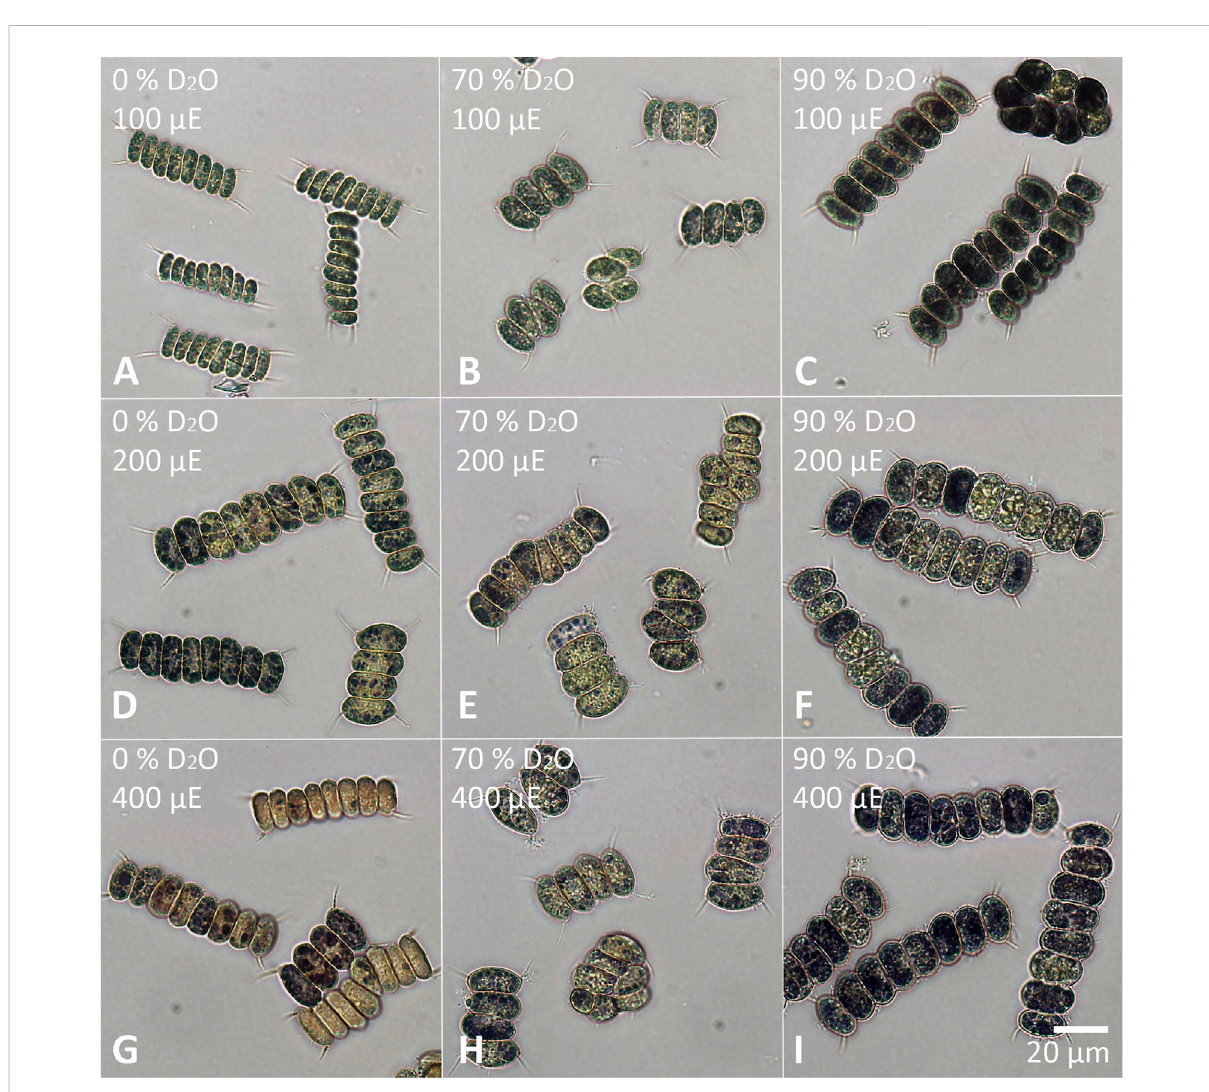
FIGURE 6 Staining of D. quadricauda with Lugol ’ s solution. Cells grown in 0 (A,D,G) , 70 (B,E,H) or 90% (C,F,I) D2O (from left to right) at an incident light intensity of 100 (A,B,C) , 200 (D,E,F) or 400 (G,H,I) μ mol photons · m − 2 · s − 1 (denoted as μ E in the fi gure; from top to bottom) were stained after 48 h of cultivation. The starch granules appear dark purple to